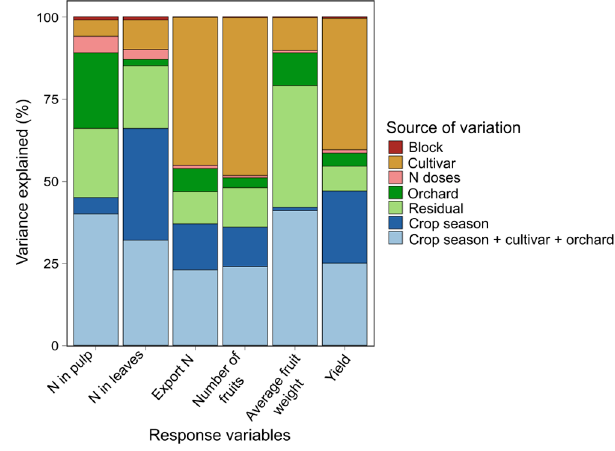
Figure 3. Proportion of variance of each variable explained by each source of variation. The colors represent the source of variation (N doses, crop season, cultivar, orchard, block, residual and the interaction: crop season ∗ cultivar ∗ orchard).